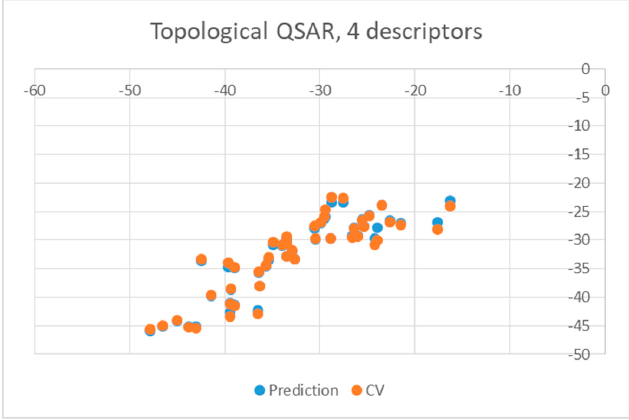
Figure 4. Obtained topological QSAR results obtained with four descriptors for mutants.